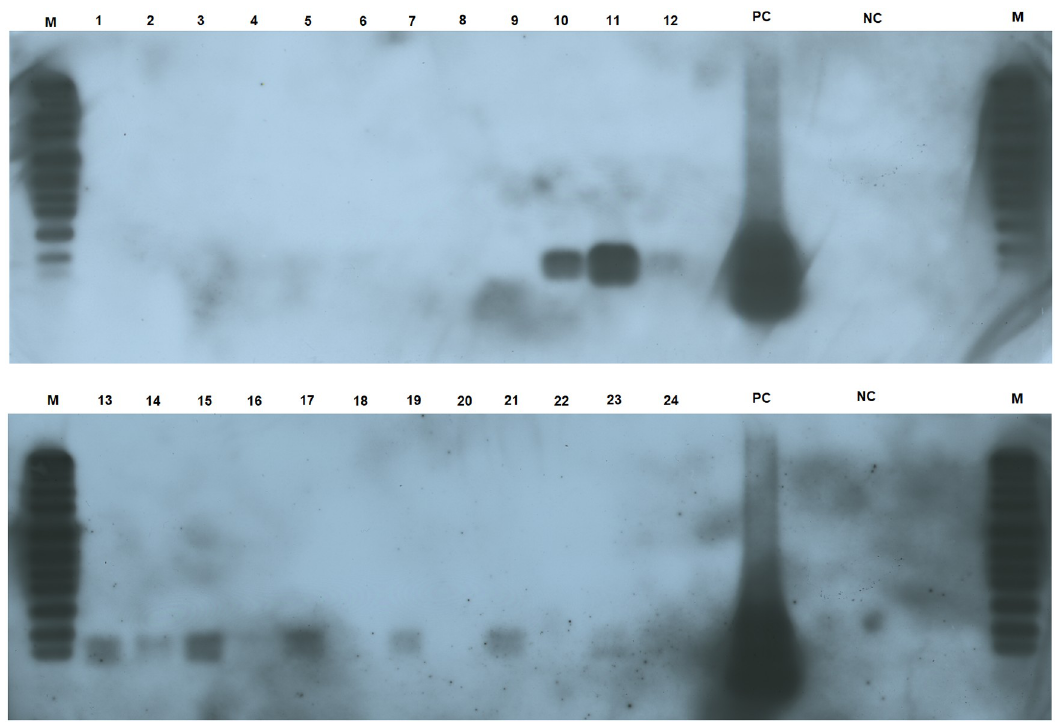
Fig 5. PCR-Southern blot using a probe for IncP-1 β subgroup. Lanes: 1–3: Mowing/4 days; 4–6: Glyphosate/4 days; 7–9: Mowing/ 10 days; 10–12: Glyphosate/10 days; 13–15: Mowing/17 days; 16–18: Glyphosate/17 days; 19–21: Mowing/26 days; 22–24: Glyphosate/26 days; M = marker DIGVII; PC: positive control (amplification product of IncP-1 β plasmid pR751); NC: negative control. Exposure time: 30 min. In those lanes in which no bands were detected, the same result was observed after a longer exposure time. Size of the smallest band of DIGVII marker: 359